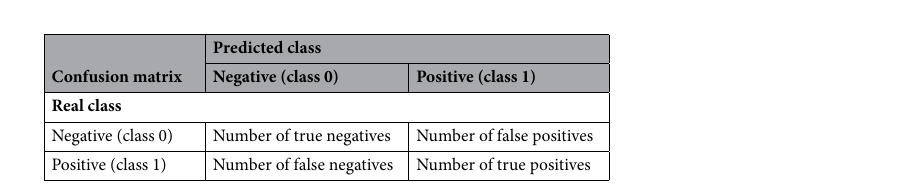
Table 3. Basic framework of the confusion matrix.